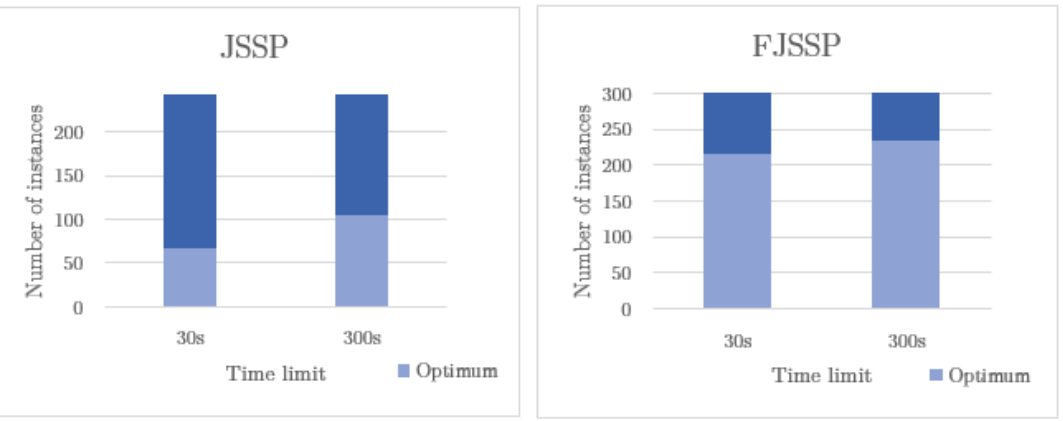
Figure 4. Optimal results for JSSP and FJSSP .